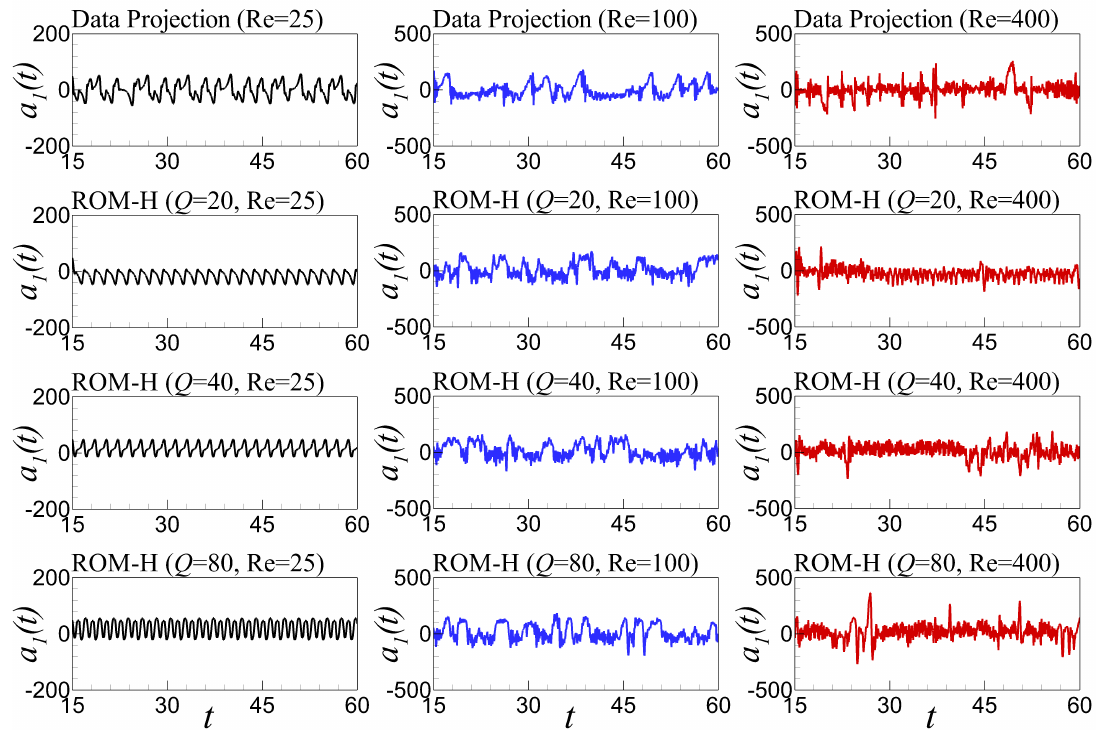
Figure 19. Sensitivity analysis with respect to the number of ELM neurons of ROM-H approach using time series of the first modal coefficient, a 1 ( t ) for Re = 25,100,400 and Q = 20,40,80.